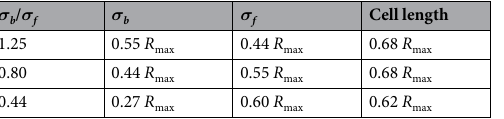
Table 1. Size parameters for the cells. Cell length is given as the length of the cell in its steady